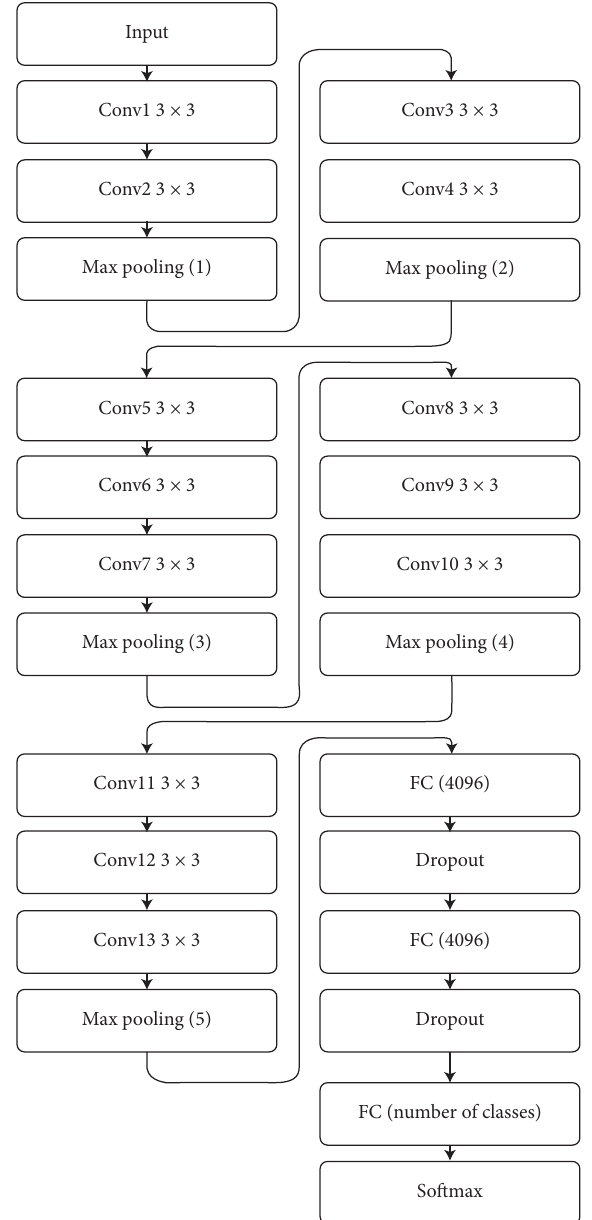
Figure 3: Deep learning VGG face architecture.